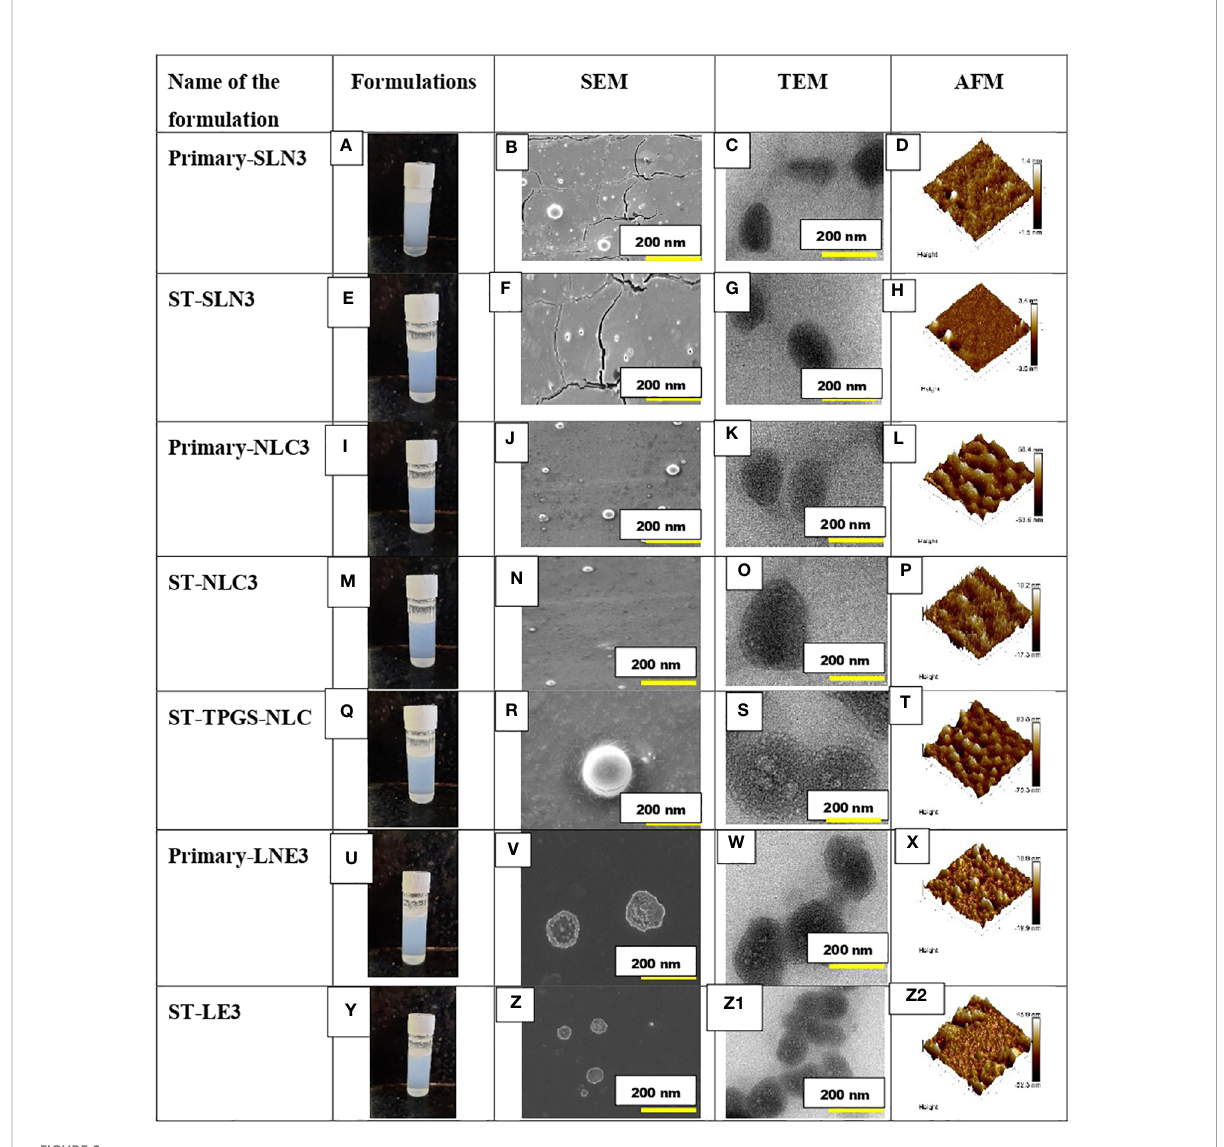
FIGURE 2 (A-D) represents the outline, SEM, TEM and AFM image of Primary-SLN3. (E-H) represents the outline, SEM, TEM and AFM image of ST-SLN3. (I-L) represents the outline, SEM, TEM and AFM image of Primary-NLC3. (M-P) represents the outline, SEM, TEM and AFM image of ST-NLC3. (Q-T) represents the outline, SEM, TEM and AFM image of ST-TPGS-NLC. (U-X) represents the outline, SEM, TEM and AFM image of Primary- LNE3. (Y-Z2) represents the outline, SEM, TEM and AFM image of